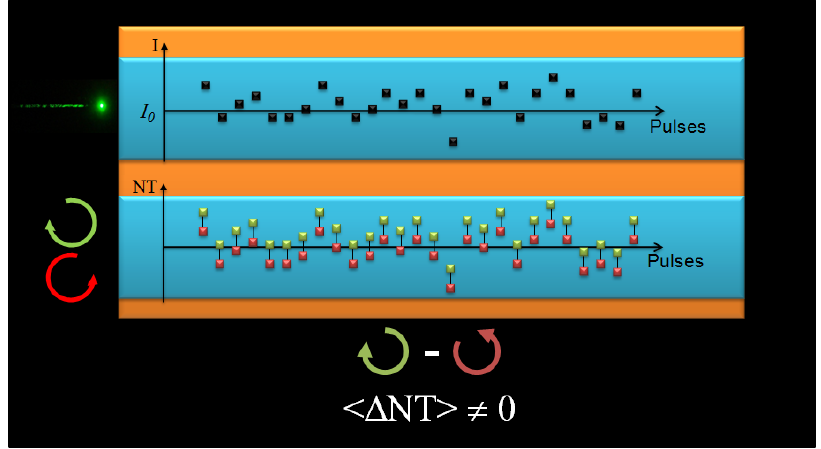
Figure 5. Depiction of TPA measurements performed using the double L-scan technique. Excitation using RCPL (green solid squares) and LCPL (red solid squares). Top represents the intensity (I) of the individual pulses exciting the sample and bottom represents the normalized transmittance (NT) measured trend for each individual pulse for both circular